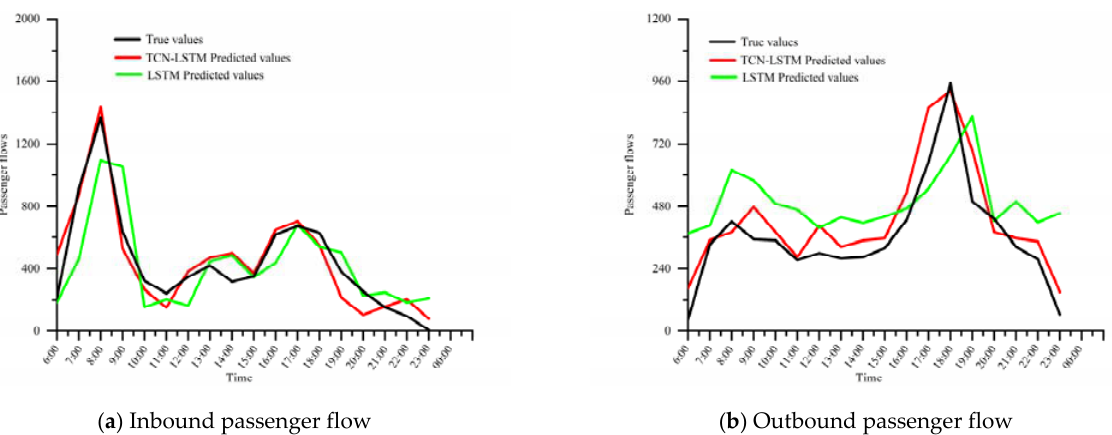
Figure 16. Prediction results of passenger flow at Longtousi (Low passenger flow).